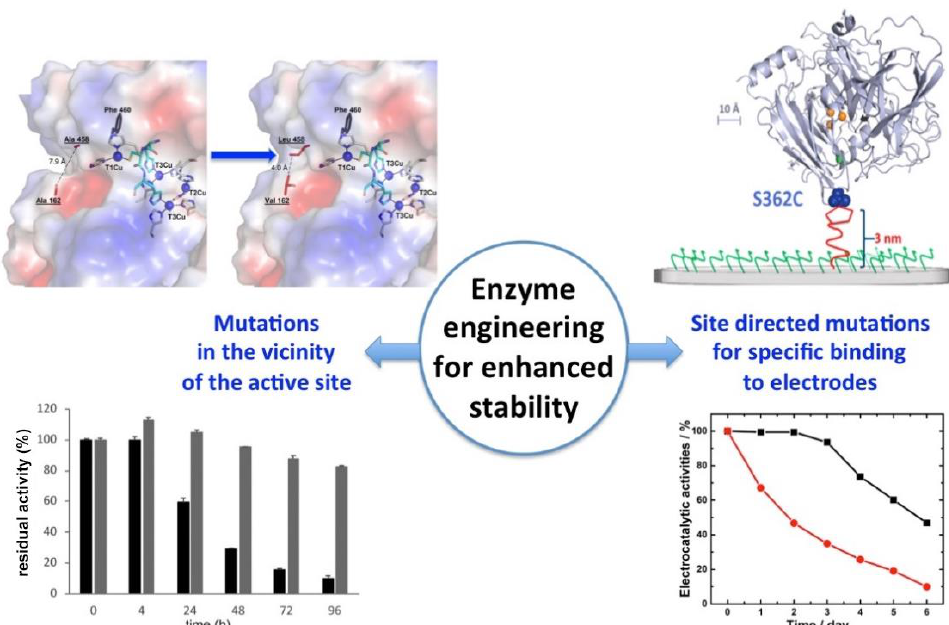
Figure 11. Enzyme engineering strategies for enhanced stability. ( Left ) Mutations in the vicinity of the active site; computer-guided mutagenesis and directed evolution of a fungal LAC in CuT1 vicinity induce enhanced stability at pH 4 compared to the WT. Reproduced with permission from [243]. ( Right ) Covalent immobilization of BOD through site-directed mutagenesis and reaction with maleimide groups on the electrode surface induce enhanced stability of the mutant (black curve) compared to the WT (red curve). Adapted with permission from